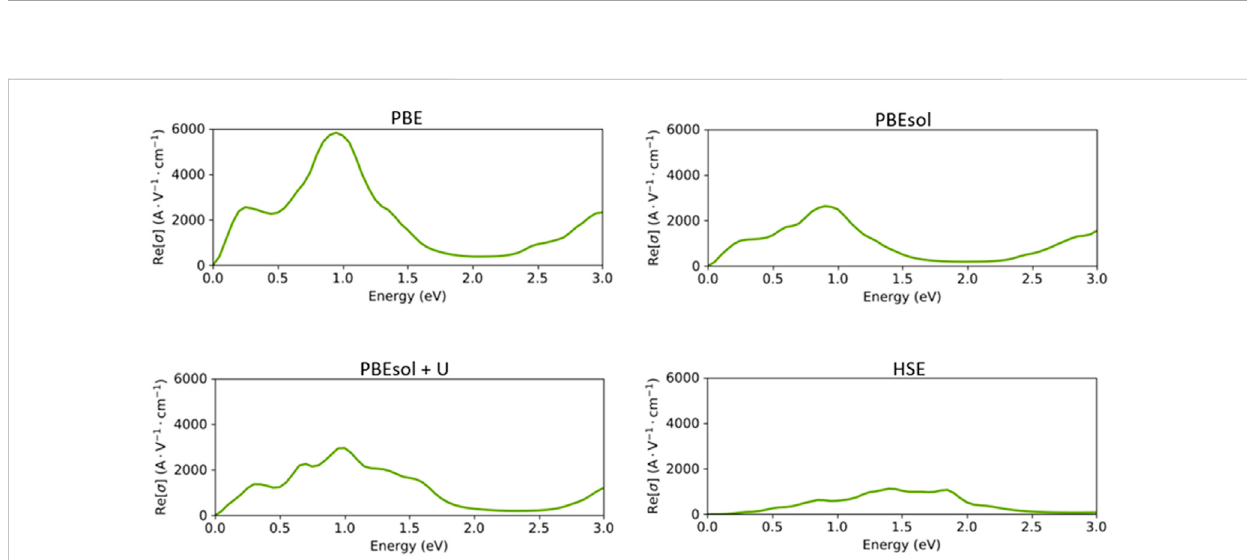
FIGURE 7 Optical conductivity of the VO 2 (M) structure as a function of the energy (eV), predicted by the PBE, PBEsol, PBEsol + U, and HSE functionals.